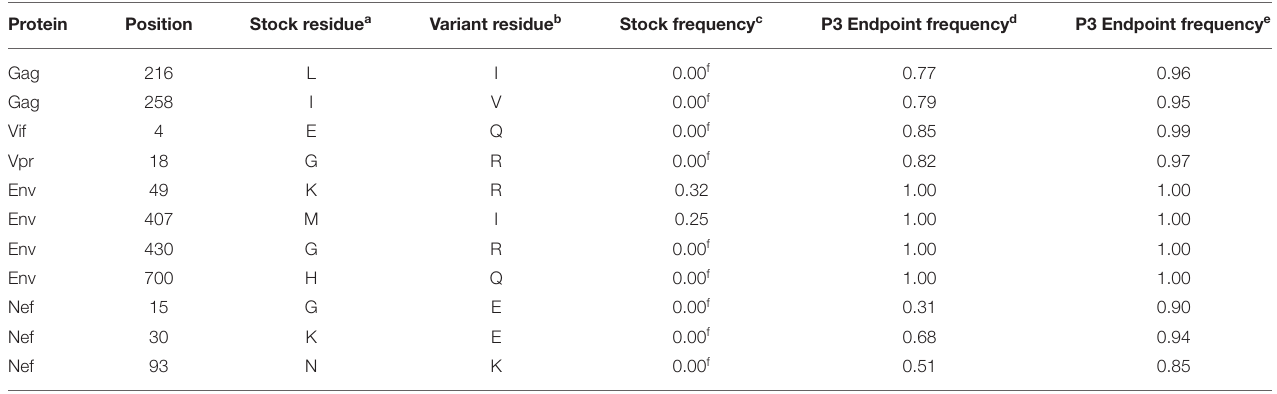
TABLE 3 | Amino acid substitutions accumulated during three passages of SIVhu in hu-mice.